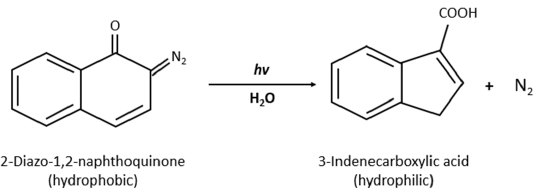
Figure 8. Hydrophobic to hydrophilic change of DNQ after Wolff rearrangement induced by UV/NIR light in buffered water. A study published recently has expanded the work of Goodwin et al. [41] using a similar micellar formulation with DNQ as a ligand [42]. In this study, micelles were loaded with docetaxel (DTX) as an anti ‐ cancer drug to assess the cytotoxicity of the micellar for ‐ mulation when irradiated with UV light. Authors incubated MCF ‐ 7 (breast cancer cell line) cells with targeted micelles (NPDNQ) both empty and loaded with docetaxel: NPDNQ and DTX ‐ NPDNQ. When irradiated with UV light at λ = 395 nm (50 mW/cm 2 ) for 10 min and after an incubation of 24 h, cells viability of DTX ‐ NPDNQ decreased from 55% (before irradiation) to 36% (after irradiation) [42]. On the other hand, empty NPDNQ showed no significant difference in cells viability before and after irradiation. The authors